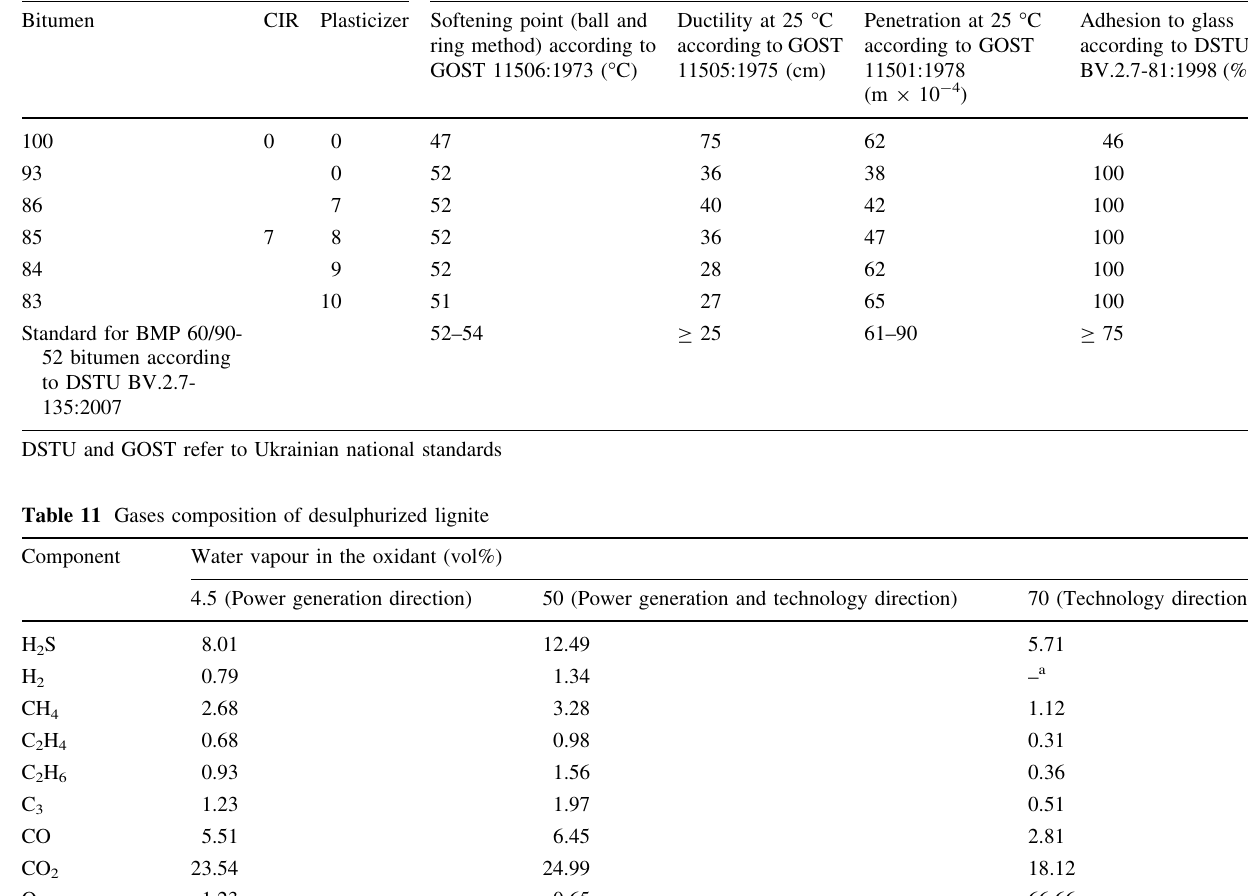
Table 10 Research on lignite tar as a PMBs plasticizer Blend composition (wt%) Characteristics of PMBs Bitumen